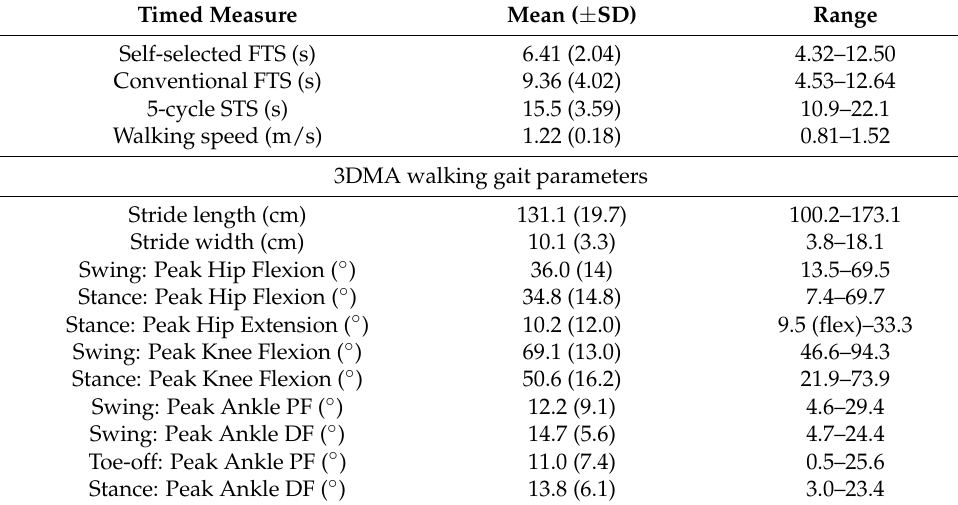
Table 4. Participants’ time performance on movement tasks, temporospatial parameters and average of peak sagittal kinematics through walking gait.